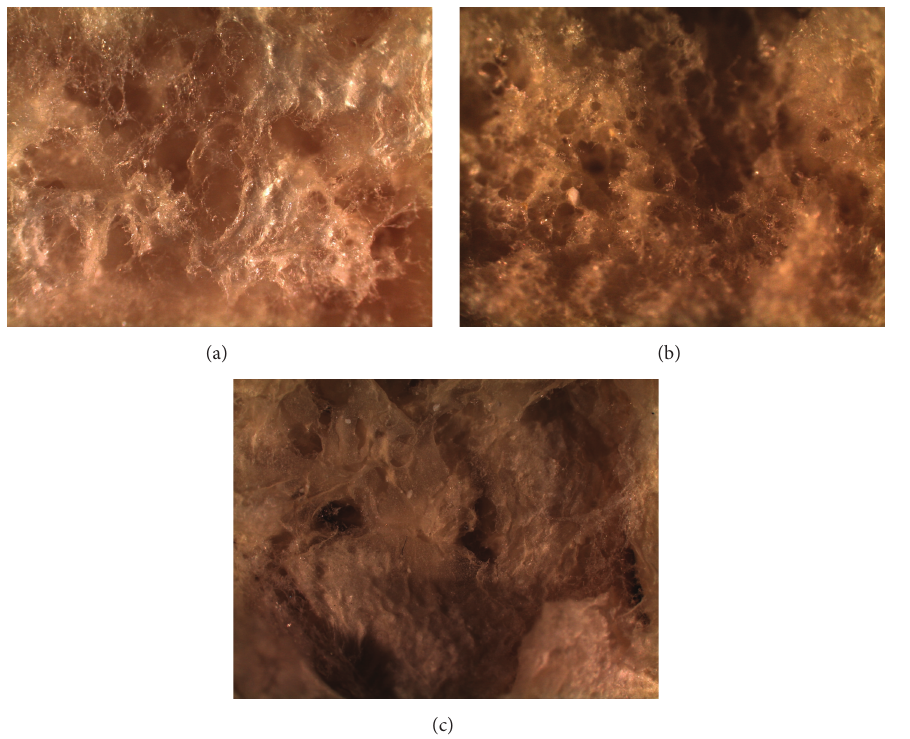
Figure 1: Optical microscopy for cross-linked samples with 25% (a), 50% (b), and 75% (c) hydroxylapatite.